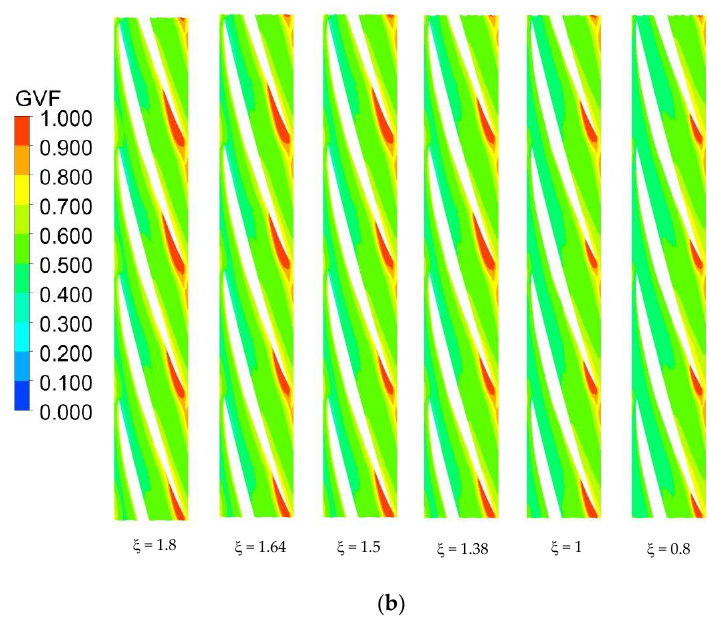
Figure 13. The gas distribution at 10% of the blade height under different thickness schemes with an inlet gas volume fraction of 0.5. ( a ) Scheme 1 with δ hmax = 7.5 mm and ( b ) scheme 4 with δ hmax = 9 mm. With the linear thickening of the blade from hub to shroud, di ff erent values of the thickness ratio coe ffi cient ξ corresponded to di ff erent profile lines of the blade; the profile of the pressure side was the same when the thickness ratio coe ffi cient ξ changes. The changes in the airfoil thickness impacted